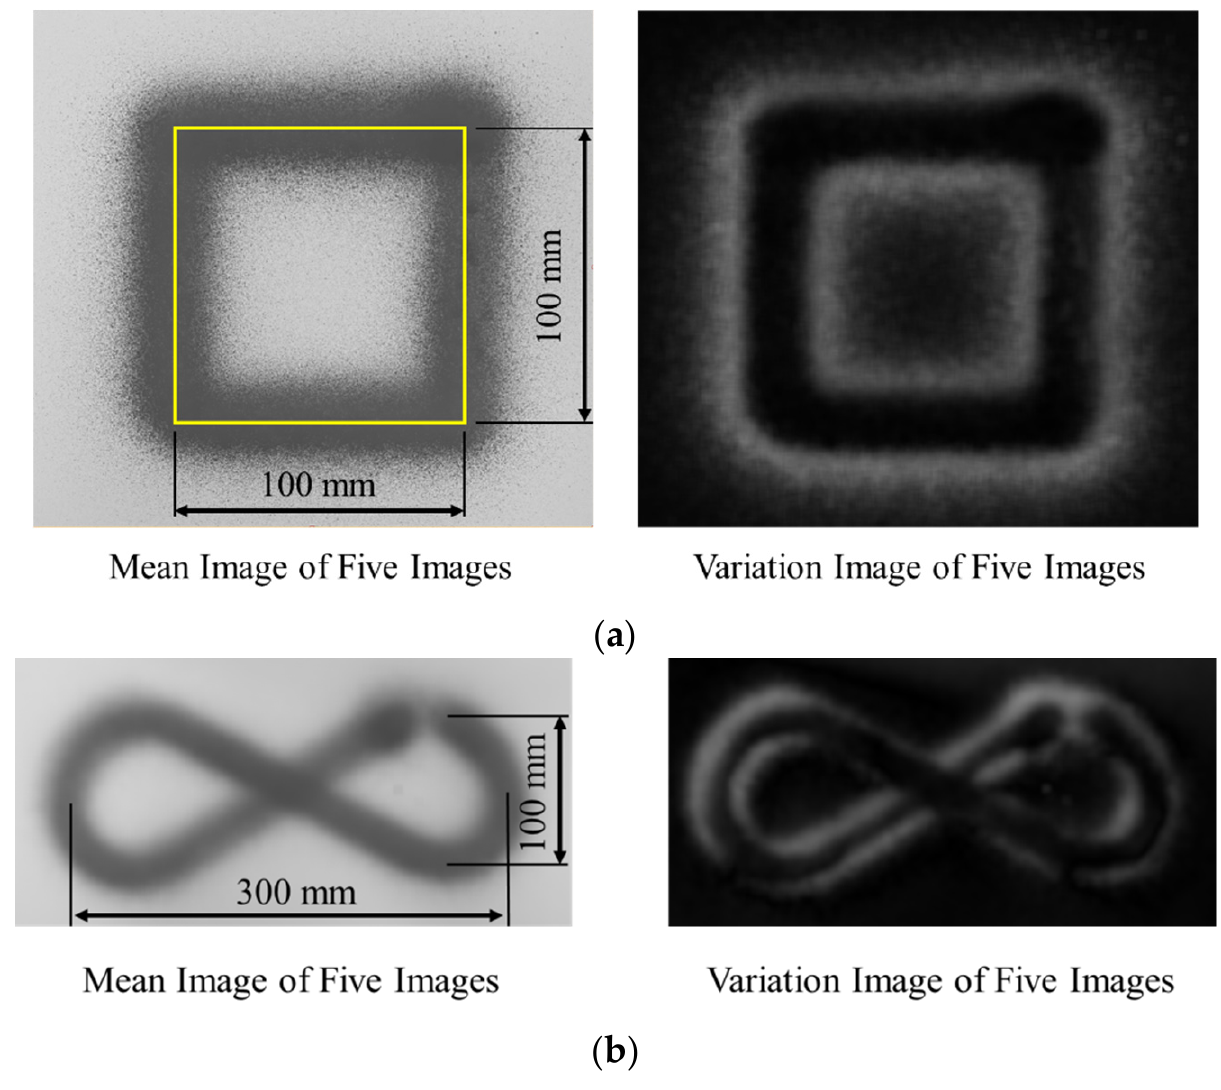
Figure 10. The Mean and Variation Images of Patterns: ( a ) Square Shape and ( b ) Infinity Symbol . Table 1. Root mean square error (RMSE) of square shape and infinity symbol